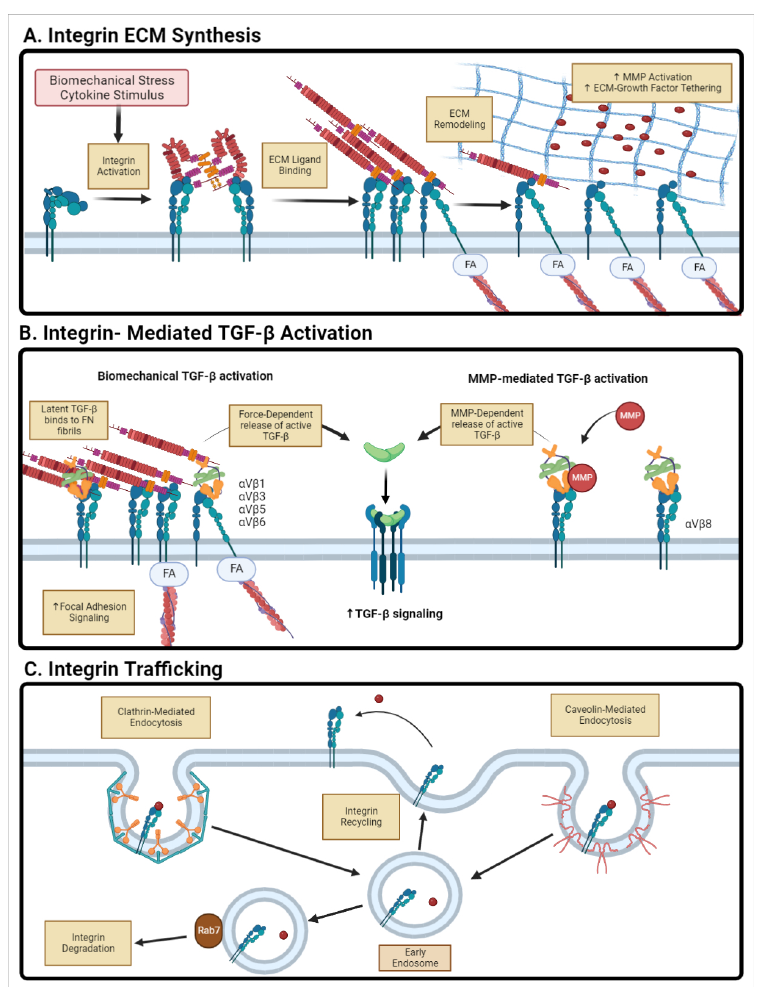
Figure 2. Schematic of integrin signaling in renal fibrosis. ( A ) ECM proteins act as integrin ligands that activate downstream signaling that promotes ECM synthesis and assembly. Increased ECM assembly opens tethering sites for growth factors and MMPs that further promote fibrogenesis. ( B ) Integrins are critical in regulating TGF- β signaling through the mechanical-dependent and MMP- dependent release of active TGF- β from LAP. ( C ) Integrin endocytosis mediates ECM signaling. Two main pathways are shown: clathrin-mediated and non-clathrin-mediated endocytosis. Renal fibrosis sees increased recycling of integrins back to the cell surface that promotes continued fibrotic signaling pathways. Figure generated using